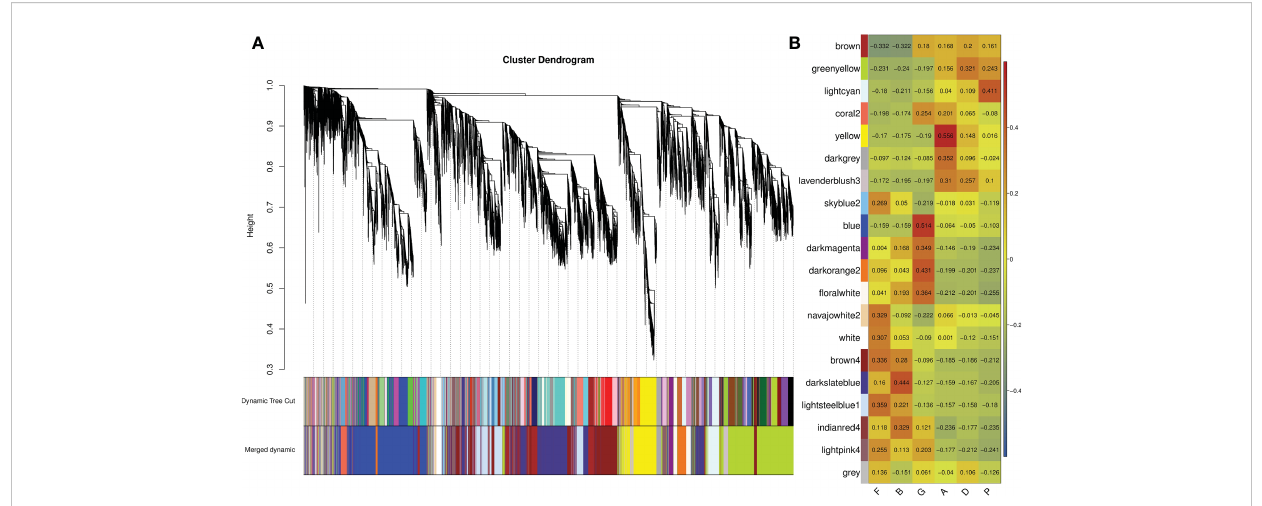
FIGURE 1 Weighted gene correlation network analysis (WGCNA) of all genes in different developmental stages. (A) Hierarchical cluster tree showing correlation modules identi fi ed by WGCNA. Each leaf in the tree represents one gene and each major tree branch represents one module, labelled with different colors. Modules with similar expression patterns are merged as merged dynamic. (B) Correlation matrix between modules and developmental stages. Red represents high expression and blue represents low